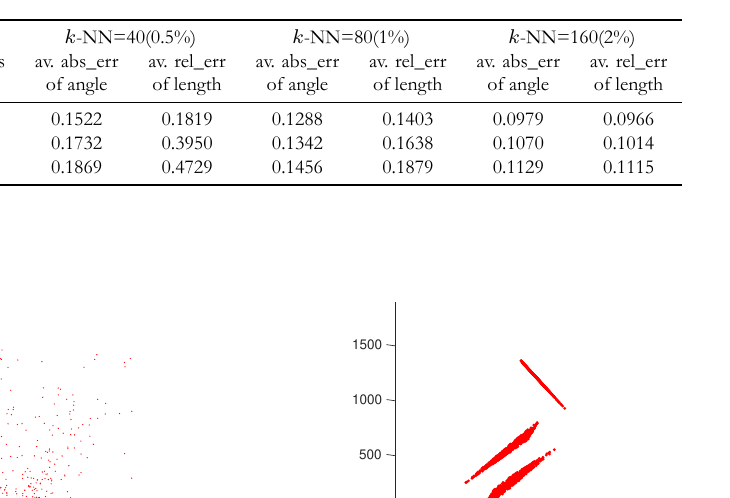
Table 4: Results of ℓ 1 MCDA on Student t -based radial data sets (with 10% outliers)